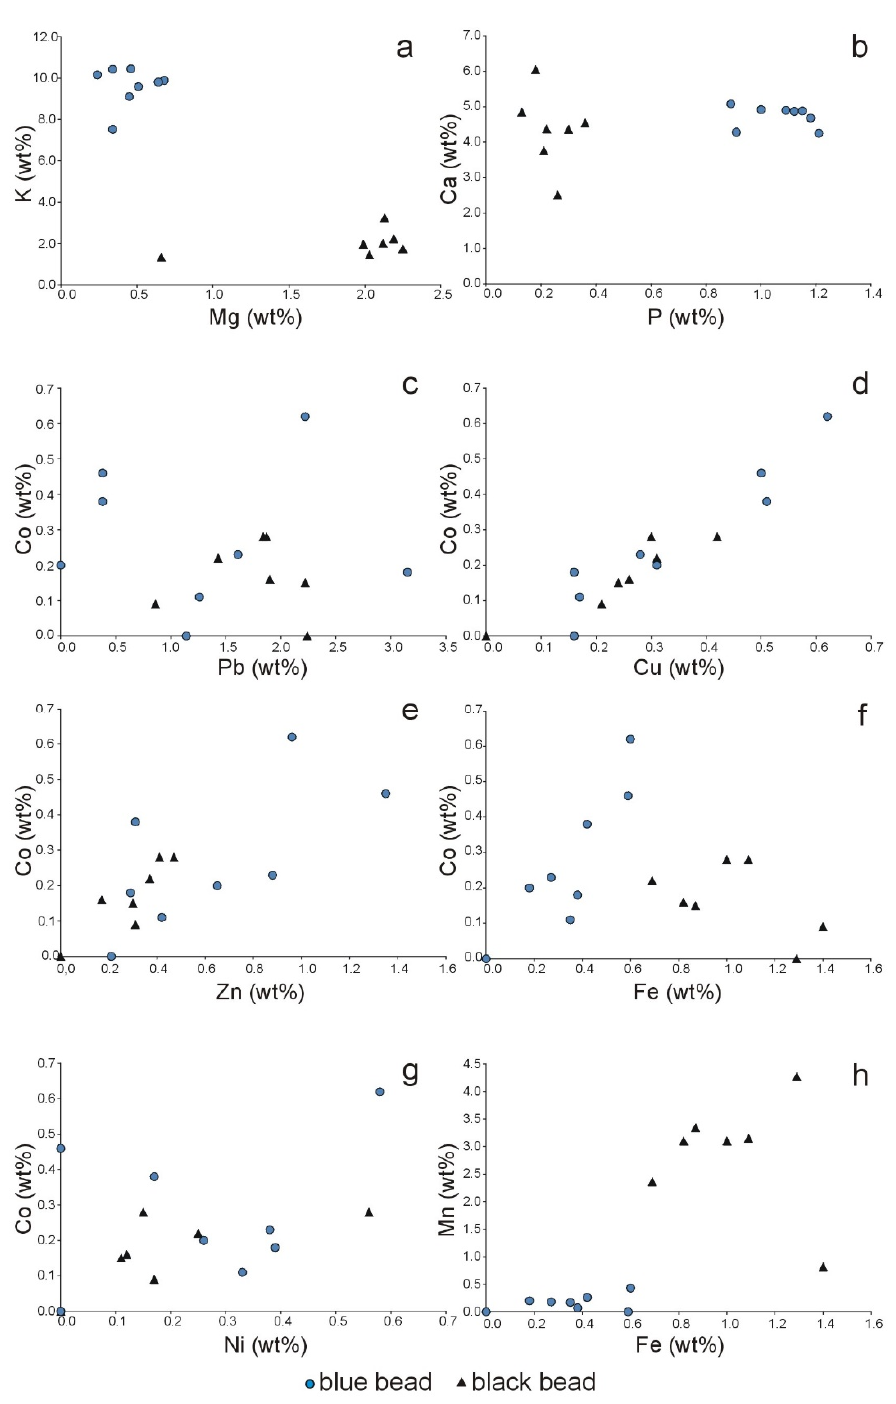
Figure 15. Associations between some of the elements detected by EDS in the analysed beads ( a – h ).